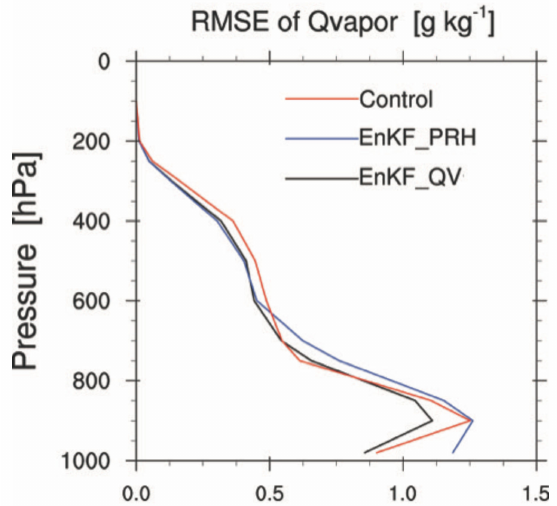
Figure 18. Vertical profile of RMSE of water vapor mixing ratio for the EnKF_QV analysis (black line), the EnKF_PRH analysis (blue line), and the control run (red line) over the 500 km × 500 km box centered on the TC averaged over all DA